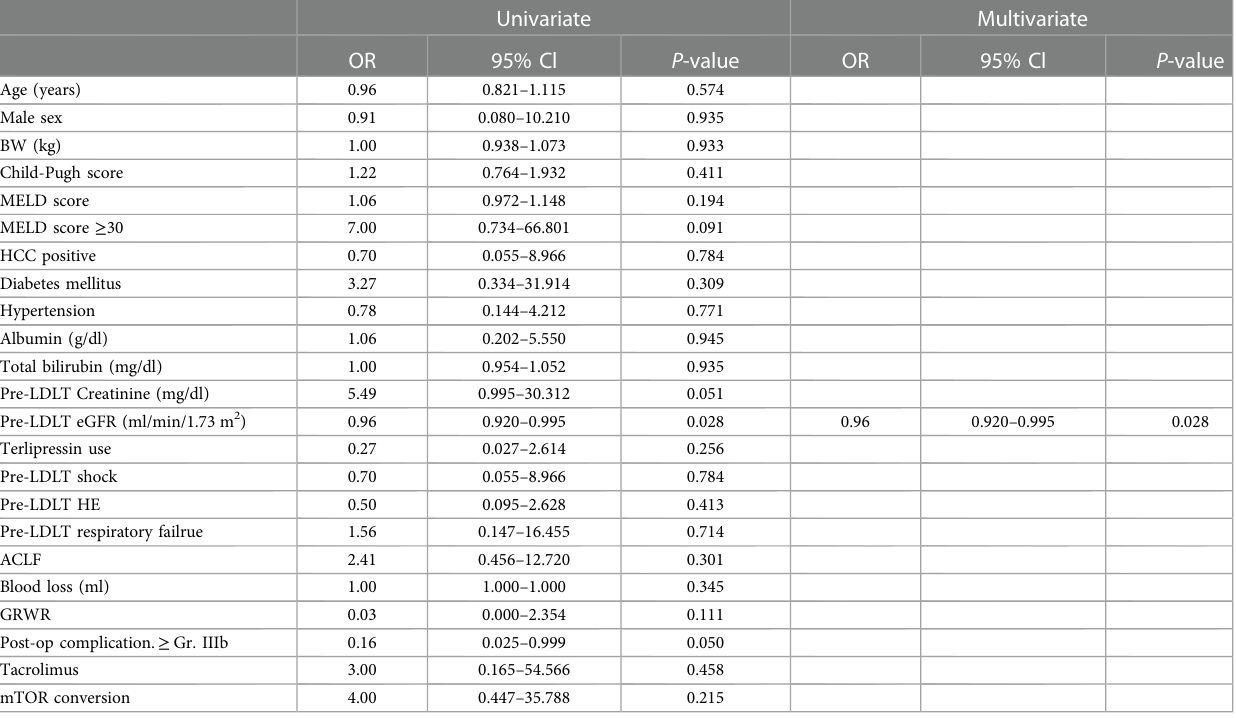
TABLE 6 Risk factors of post-LT permanent CKD for HRS patients undergoing LDLT. Univariate Multivariate OR 95% Cl P -value OR 95% Cl P